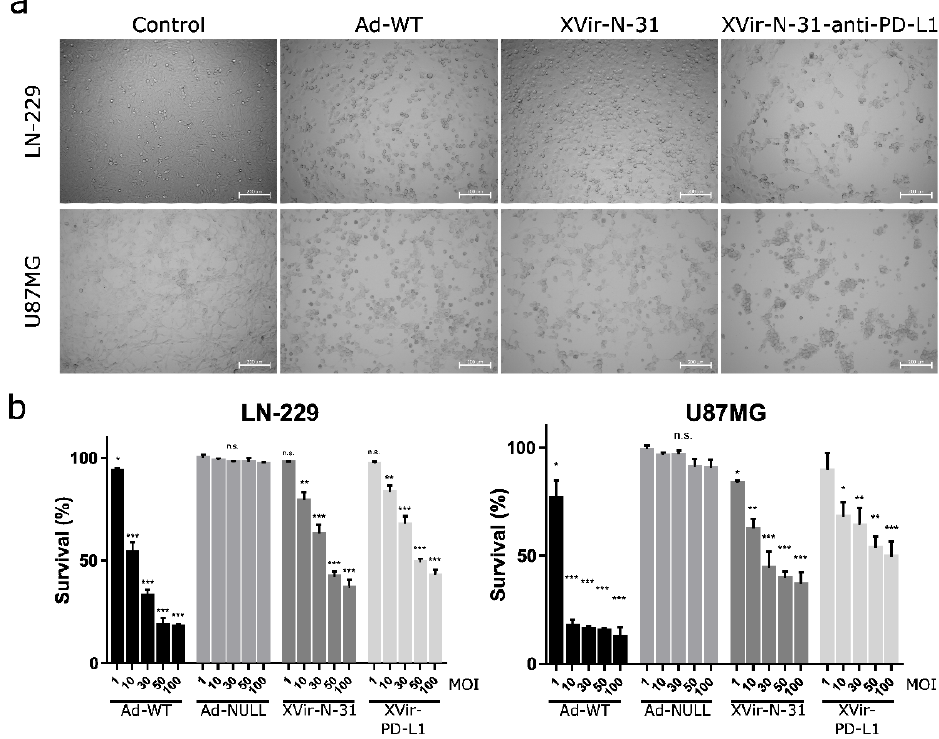
Figure 1. Cell killing activity of OAV XVir-N-31 and XVir-N-31-anti-PD-L1. ( a ) LN-229 or U87MG cells were infected with 50 MOI of Ad-WT, XVir-N-31, XVir-N-31-anti-PD-L1, or were left untreated (control). Pictures were taken 48 h later. Dead or dying cells could be identified by their rounded shape. ( b ) LN-229 or U87MG cells were infected with increasing MOI of the indicated viruses. OAV mediated cell killing was measured 48 h after infection using the MTT assay (XVir-PD-L1: XVir-N-31-anti-PD-L1; n = 3; SEM; n.s.: not significant; * p < 0.05, ** p < 0.01, *** p < 0.001).